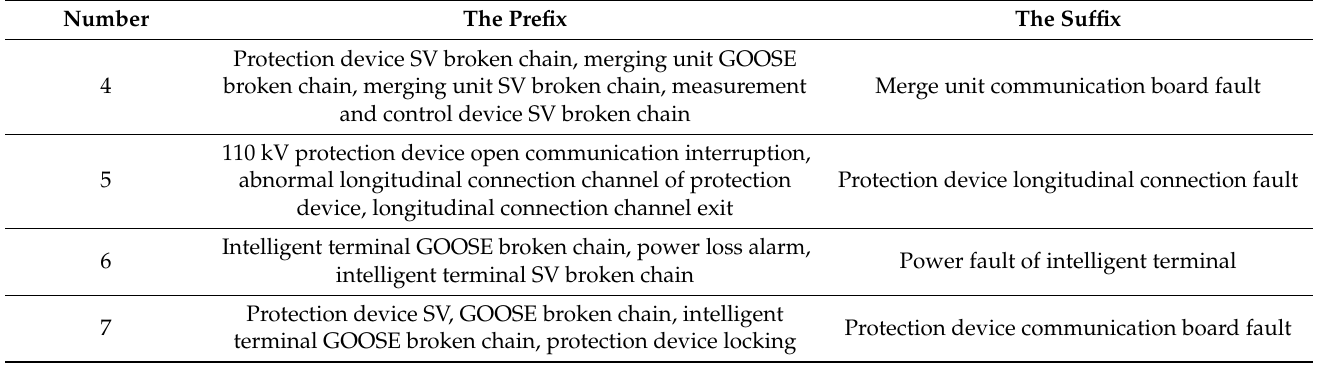
Table 4. Association rules after processing.